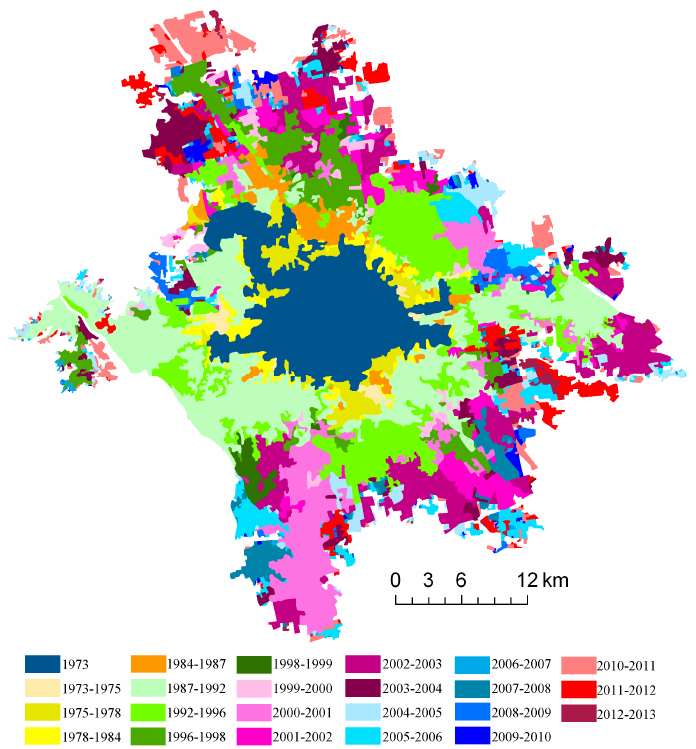
Figure 3. Urban expansion process of Beijing from the 1970s to 2013.